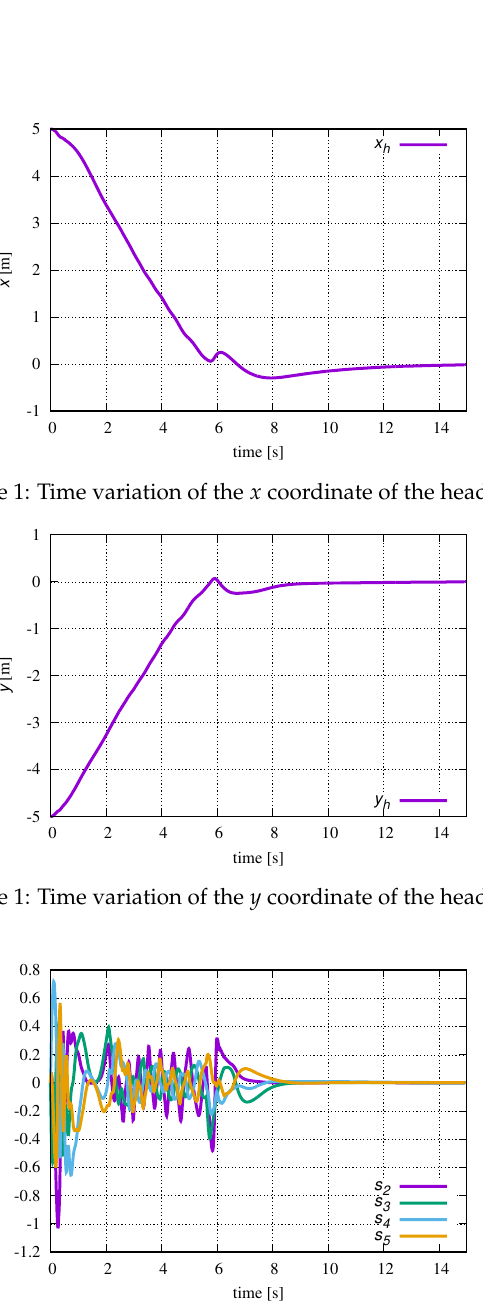
Figure 7. Case 1: Time variation of the twist angle of the springs.